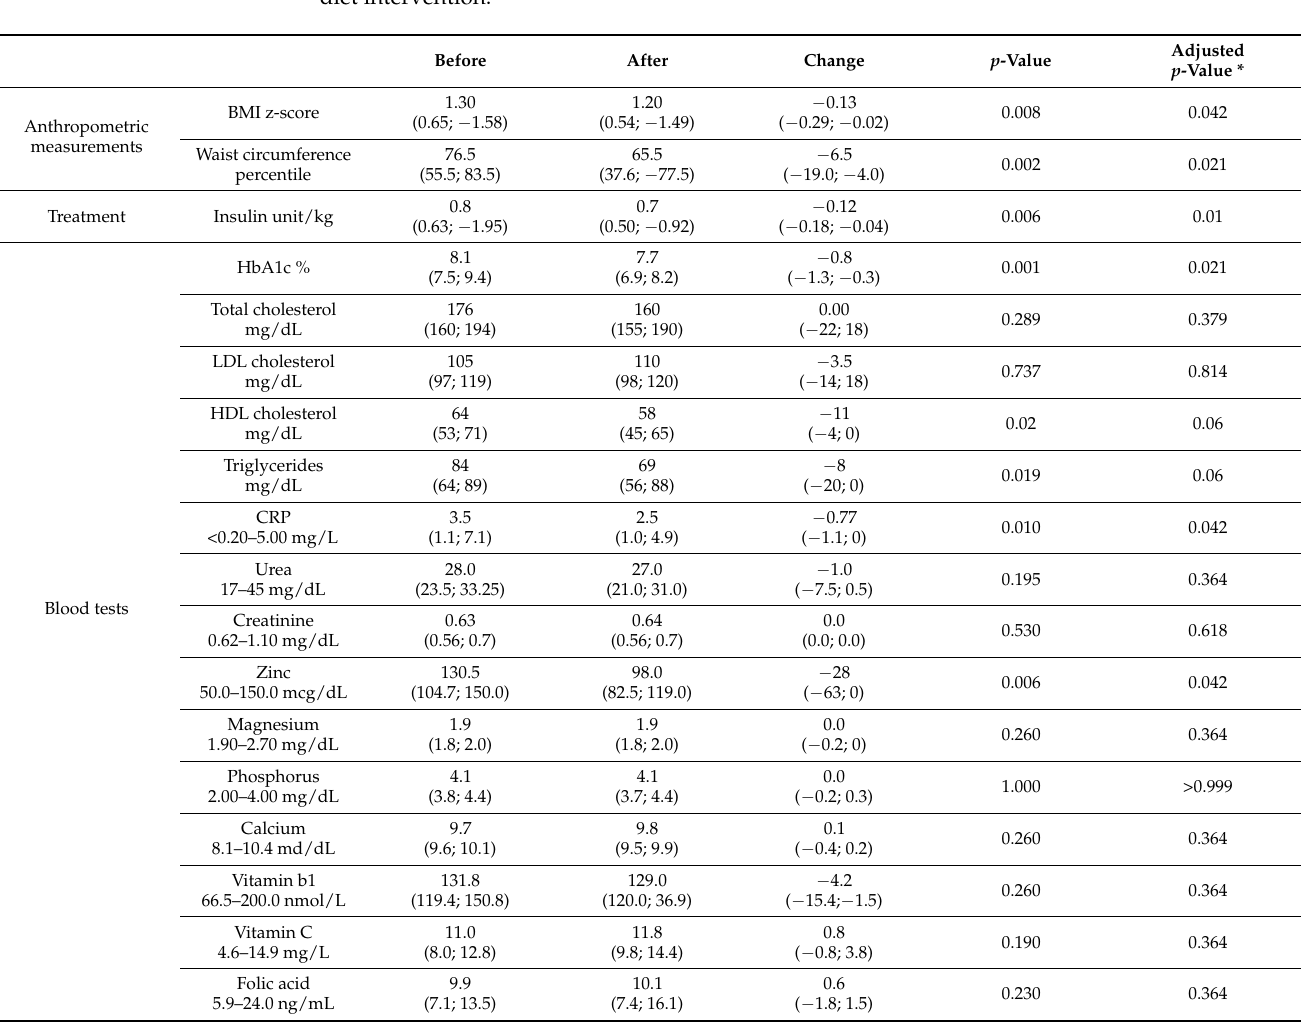
Table 2. Clinical and biochemical data of the participants before and after a low-carbohydrate diet